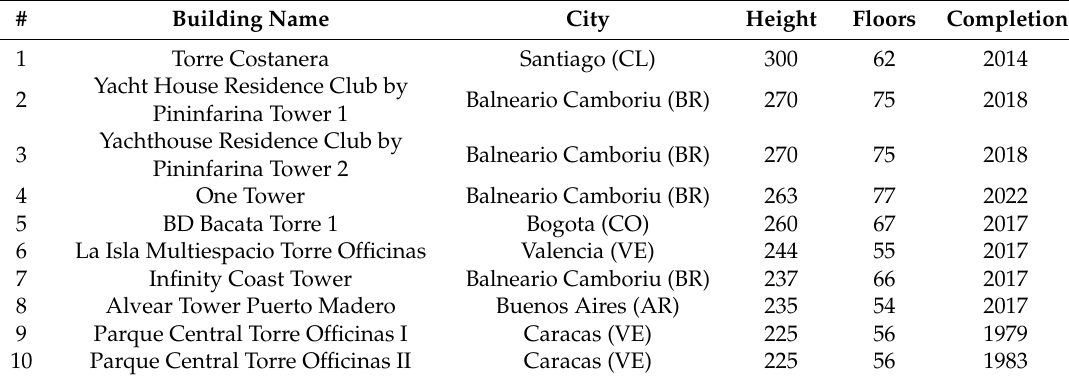
Table 10. South America’s 10 tallest skyscrapers in 2020.